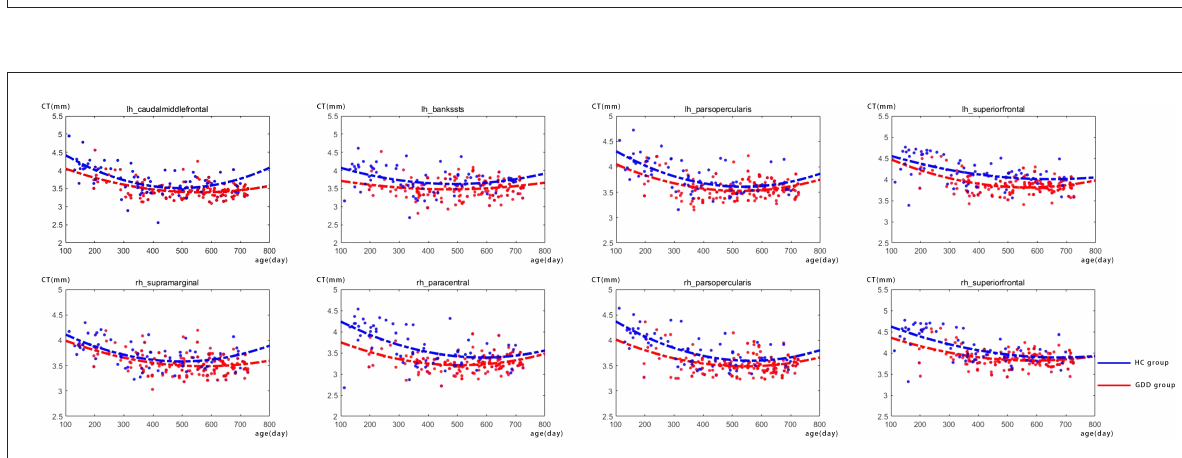
FIGURE2 There are the CT developmental trajectories of some representative regions of the two groups. The red line represents the HC group, and the blue line represents the GDD group (lh, left hemisphere; rh, right